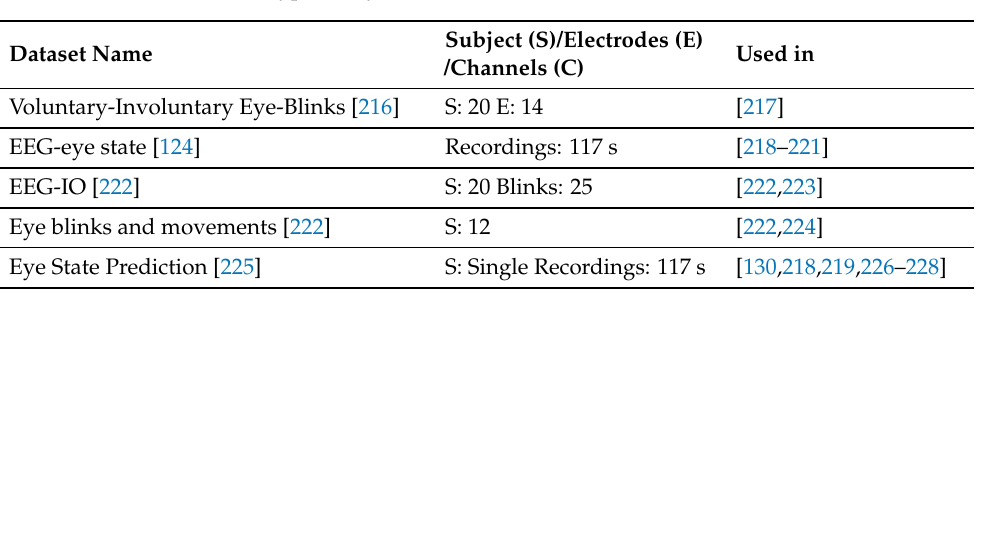
Table 6. A table of different types of eye-blink or movement datasets in